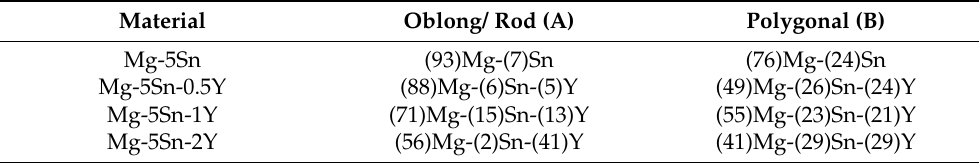
Table 3. EDS spot analysis of the secondary phases present in Mg-Sn-Y alloys (all values are in